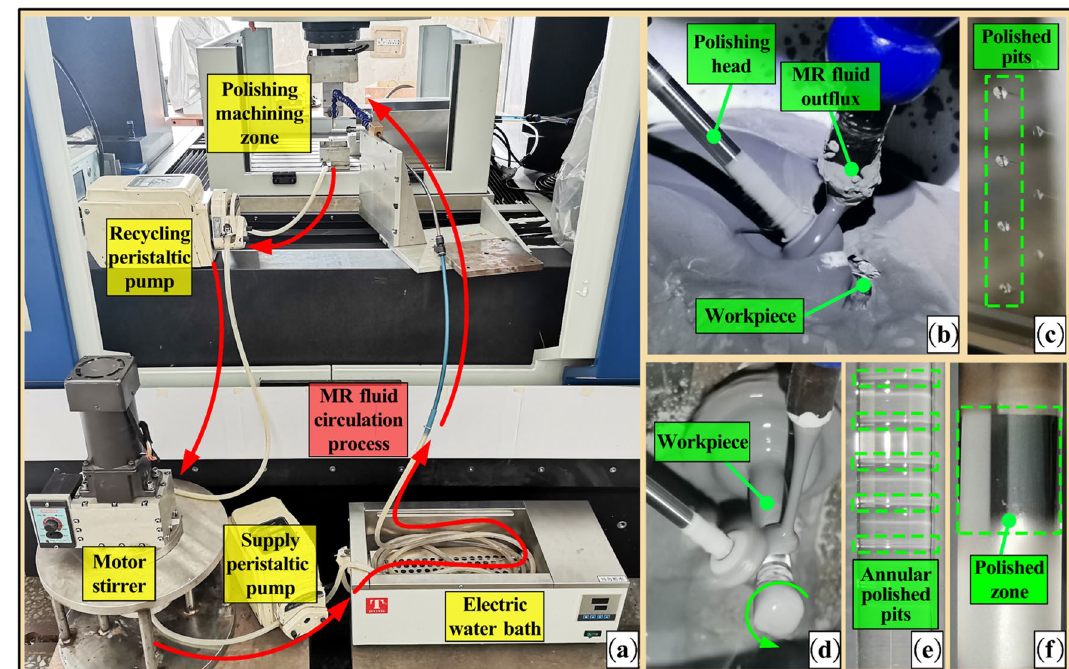
Figure 9. Schematic diagram of polishing experiment. ( a ) MR fluid circulation process and experimental equipment; ( b ) Plane glass polishing experiment; ( c ) Teardrop-shaped polished pits; ( d ) Glass rod polishing experiment; ( e ) Annular polished pits; ( f ) Polished smooth surface.